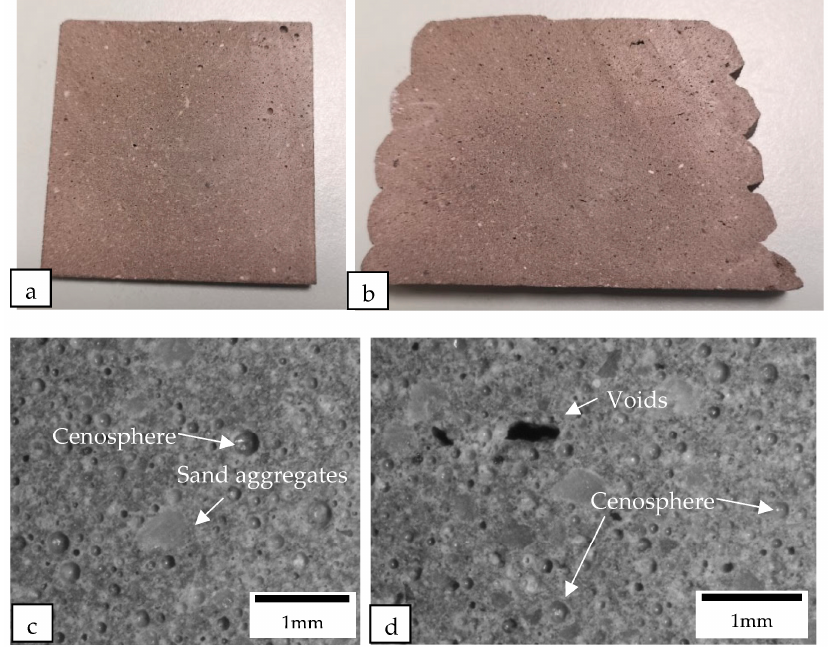
Figure 13. Cross-sectional images of ( a ) the cast and ( b ) the printed samples containing cenosphere aggregate replacement were obtained using a camera, while the macrostructure of the cross sections of ( c ) the cast and ( d ) the printed samples containing cenosphere aggregate replacement were examined under a microscope.